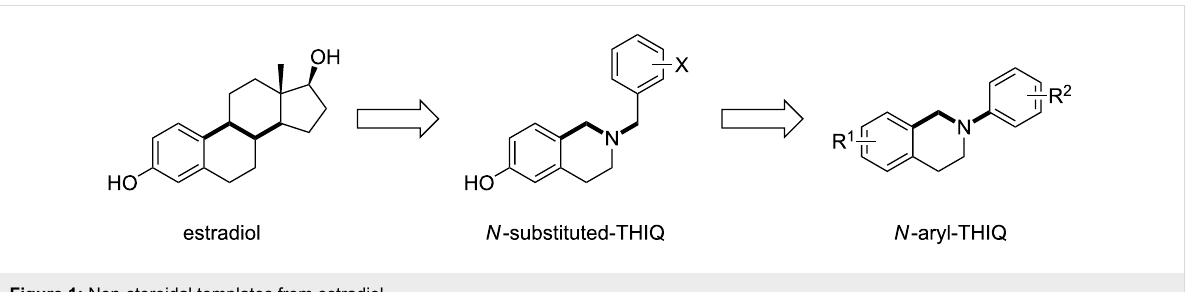
Figure 1: Non-steroidal templates from